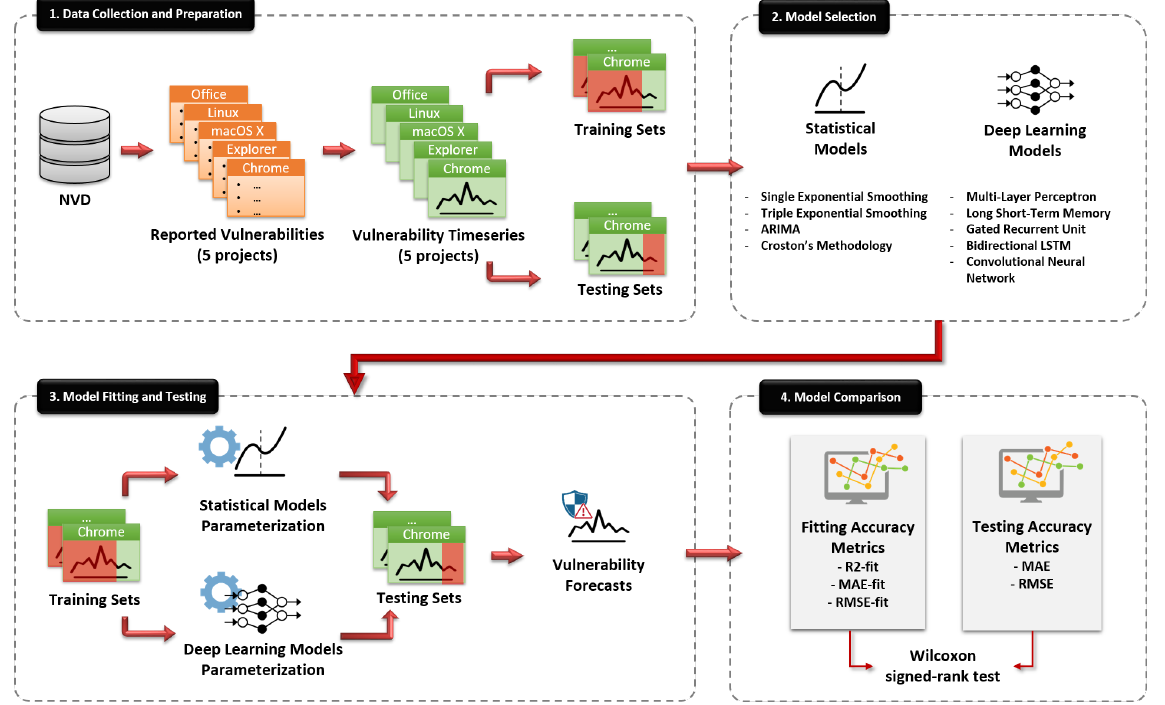
Figure 1. The high-level overview of the overall